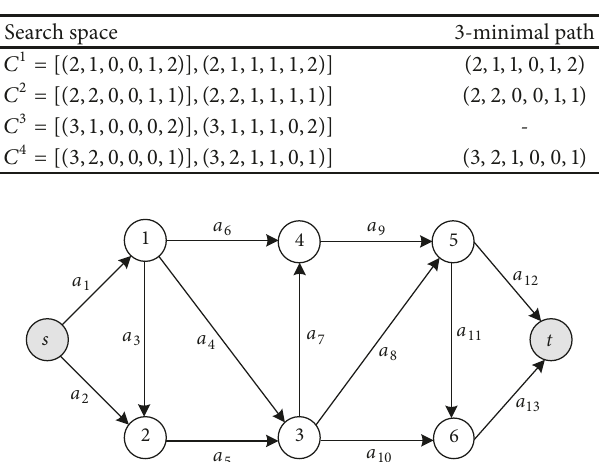
Figure 3: Ratio 𝜆 when 𝑢 𝑖 = 4.